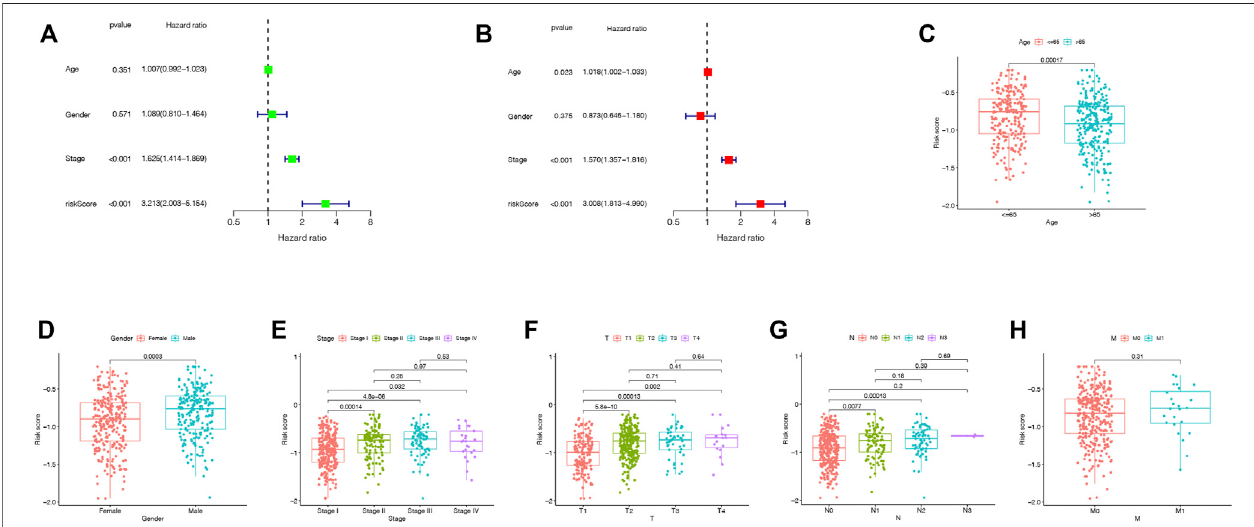
FIGURE 7 | (A,B) . Univariate and multivariate Cox regression analysis of the prognostic TRIG score in the TCGA cohort. (C-H) . Connections between clinical features and the risk groups.